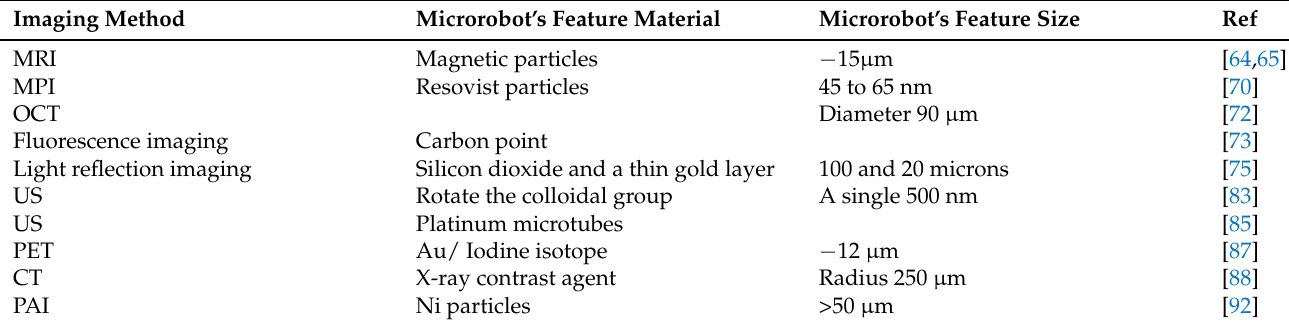
Table 2. Medical imaging technology for localizing and tracking microrobots.